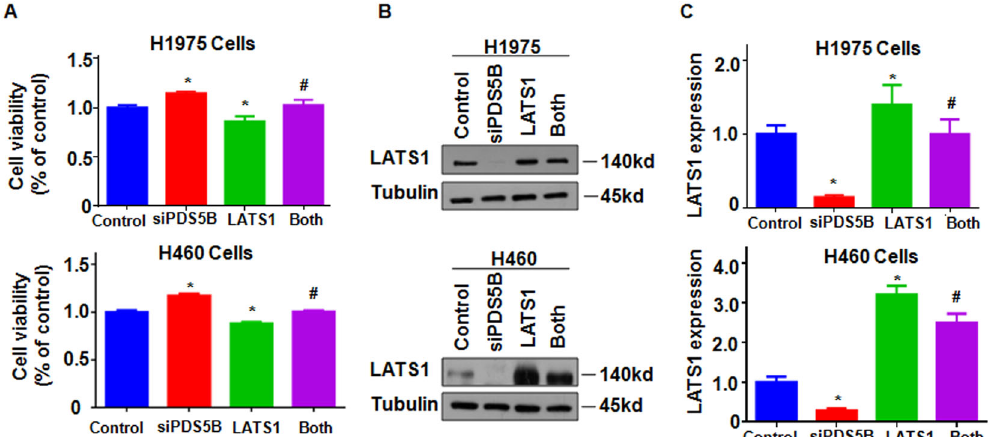
Fig. 4 Overexpression of LATS1 rescues PDS5B knockdown-induced cell viability. A Cell viability was determined by MTT assays in NSCLC cells after co-transfection of LATS1 cDNA and PDS5B siRNA. ** P < 0.05 vs control group; # P < 0.05 vs PDS5B siRNA alone or LATS1 cDNA alone. Control nonspeci fi c control siRNA and empty vector, siPDS5B PDS5B siRNA, LATS1 LATS1 cDNA, Both: siPDS5B + LATS1. Data are shown as mean ± SD from experiments in triplicate. B The expression of LATS1 was examined in NSCLC cells after co-transfection of LATS1 cDNA and PDS5B siRNA. C Quantitative data of LATS1 expression. Data are shown as mean ± SD from experiments in PDS5B overexpression increases LATS1 expression To determine the underlying mechanism of PDS5B-mediated antitumor activity in NSCLC cells, we measured the expression of LATS1 in H1975 and H460 cells after PDS5B modulation by western blotting analysis. Our data uncovered that PDS5B upregulation elevated the expression of LATS1 in H1975 and H460 cells, whereas PDS5B silencing alleviated the LATS1 expression levels in NSCLC cells (Figs. 3A, B). These results suggest that PDS5B positively regulates the LATS1 expression.